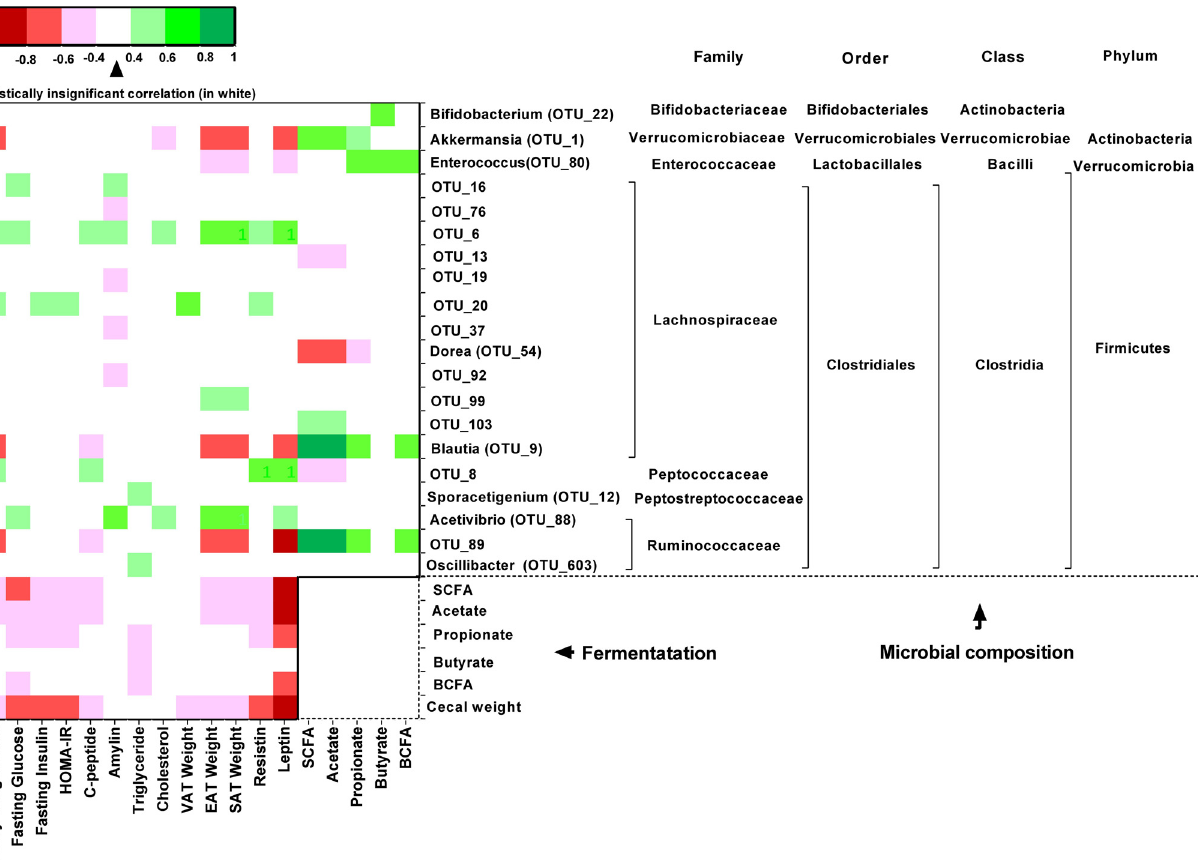
Fig 8. Correlations between relative abundance of fecal bacterial OTUs and short and branched chain fatty acids with output variables in HF and FOPS mice. Only statistically significant correlations are shaded (p <